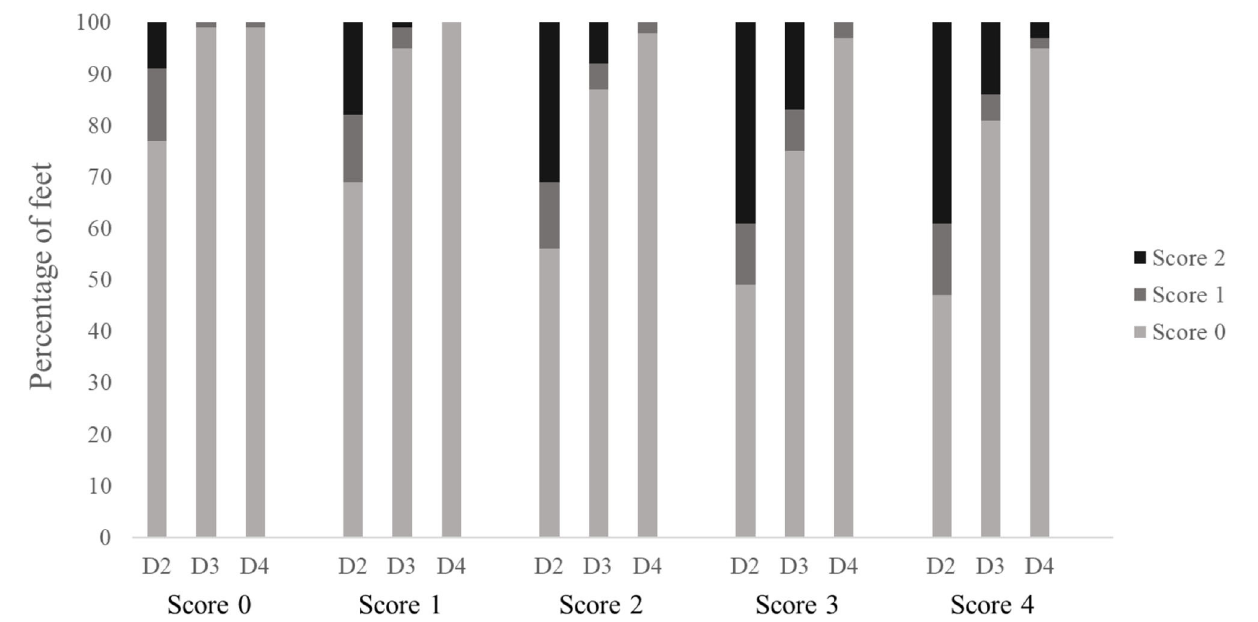
FIGURE 4 | Grade of swelling on digital pads for the different scoring levels of the standard FPD scoring system of the metatarsal pad (score 0 = intact foot; score 1 = alterations ≤ 10%; score 2 = alterations ≤ 25%; score 3 = alterations ≤ 50% and score 4 = alterations > 50%). Digits were scored separately (D2–D4). Data are presented as percentage, n = 500